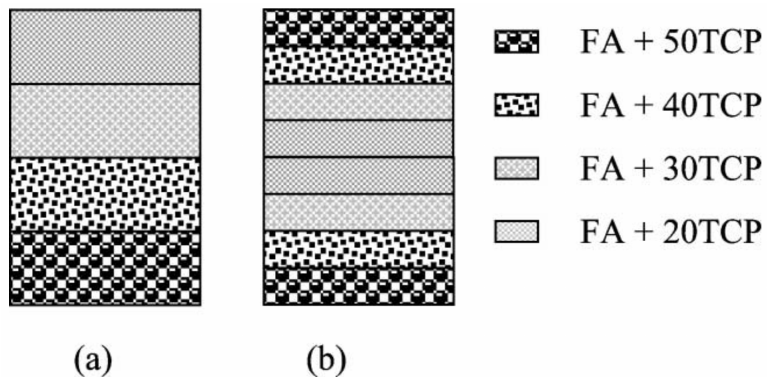
Figure 18. A schematic diagram showing the arrangement of the FA/ β -TCP biocomposite layers. ( a ) A nonsymmetric functionally gradient material (FGM); ( b ) symmetric FGM. Reprinted from Ref. [744] with